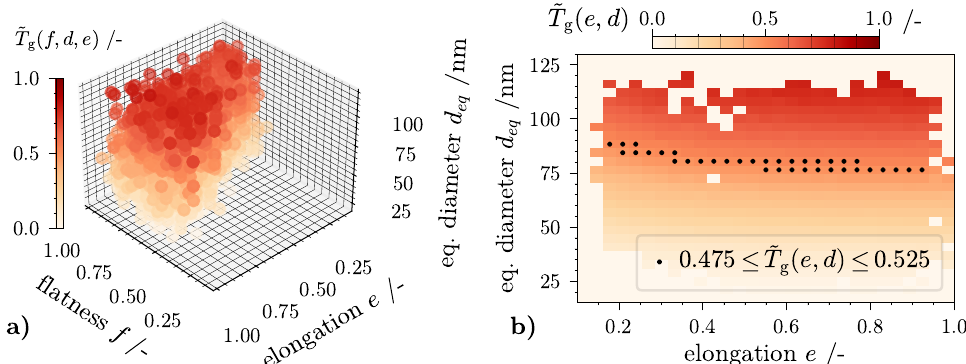
Figure 9. ( a ) Three dimensional (3D) grade efficiency ˜ T g ( f , e , d ) of virtual silicon dioxide (SiO 2 ) particle system after separation: discretization over the three distinct traits d, e and f; ( b ) Marginalized data over particle traits e and d .